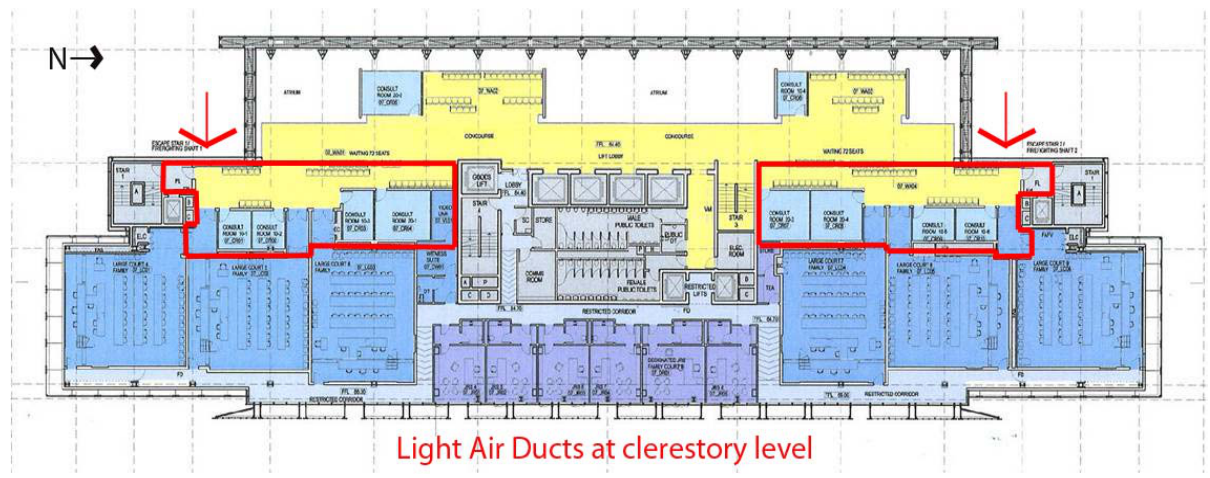
Figure 2. Court Room Floor Plan (Upper